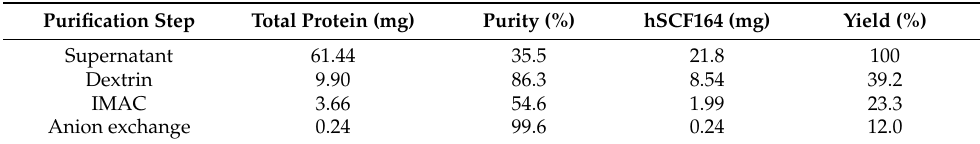
Table 3. Purification yields of hSCF164.